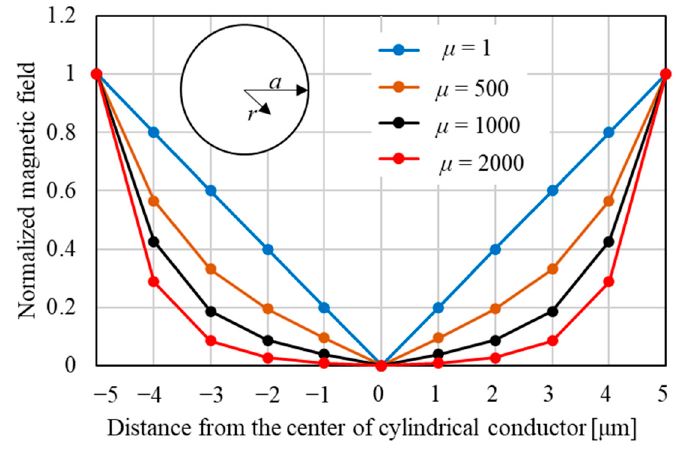
Figure 3. Permeability dependence of magnetic field distribution in cylindrical conductor.